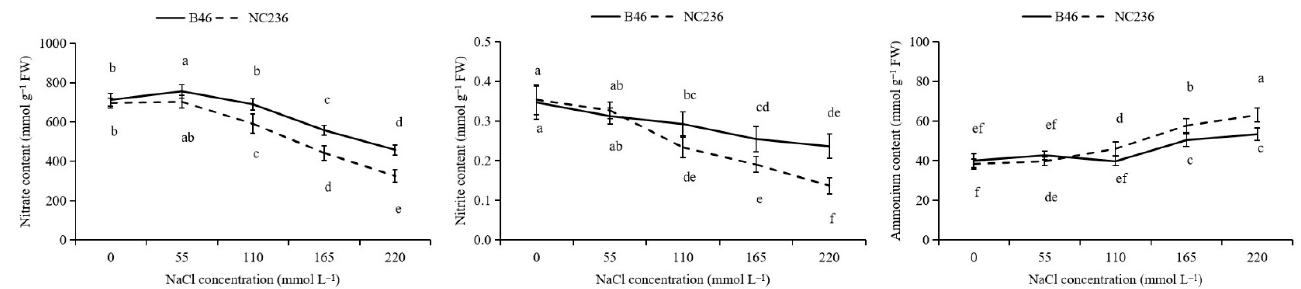
Figure 5. Effects of salt stress on the contents of nitrate, nitrite, and ammonium in maize leaves. Data are expressed as mean ± standard deviation. Different letters within the same column indicate significant difference at the 5% level.